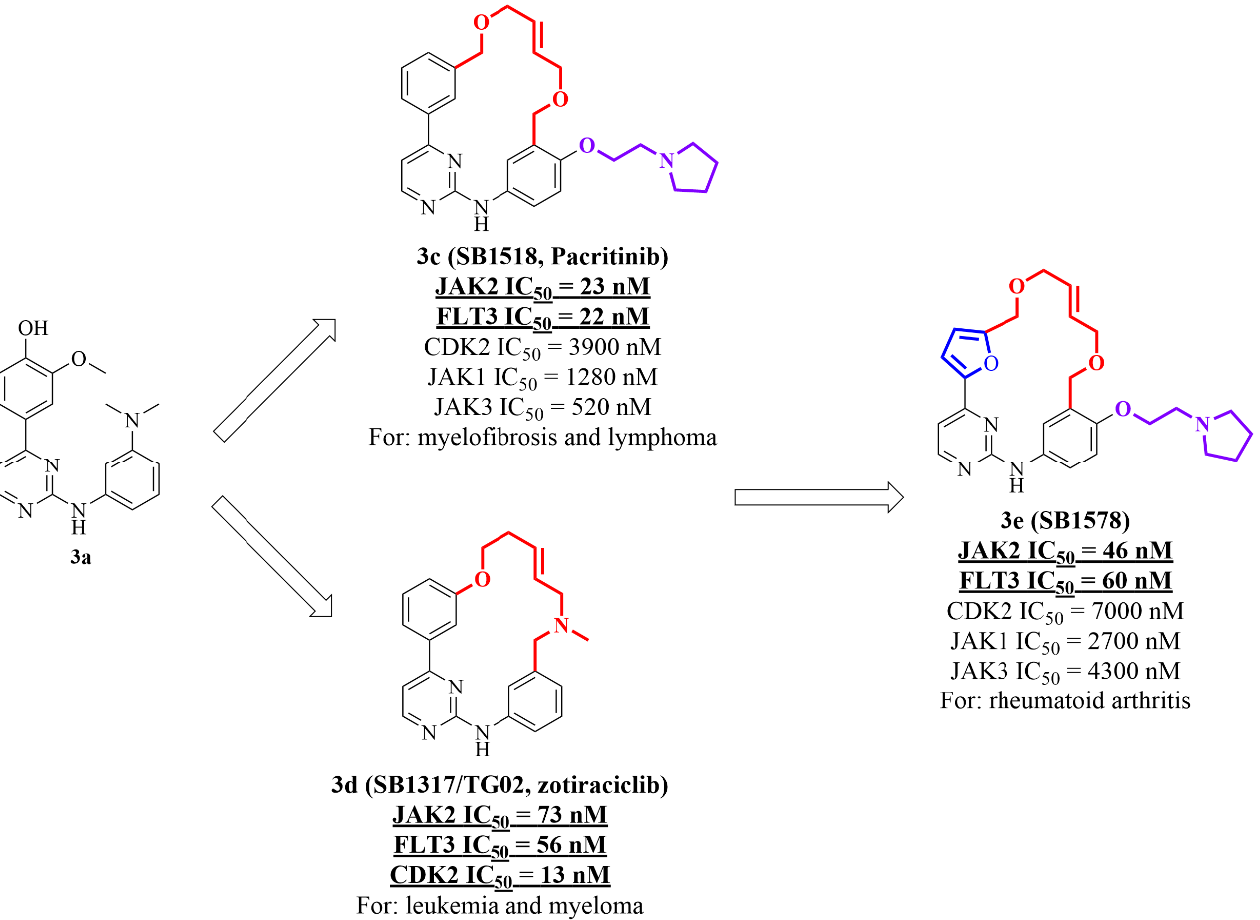
Figure 3. Overview the representative structures of various selective JAK2 macrocyclic inhibitors for the treatment of various clinical indications.